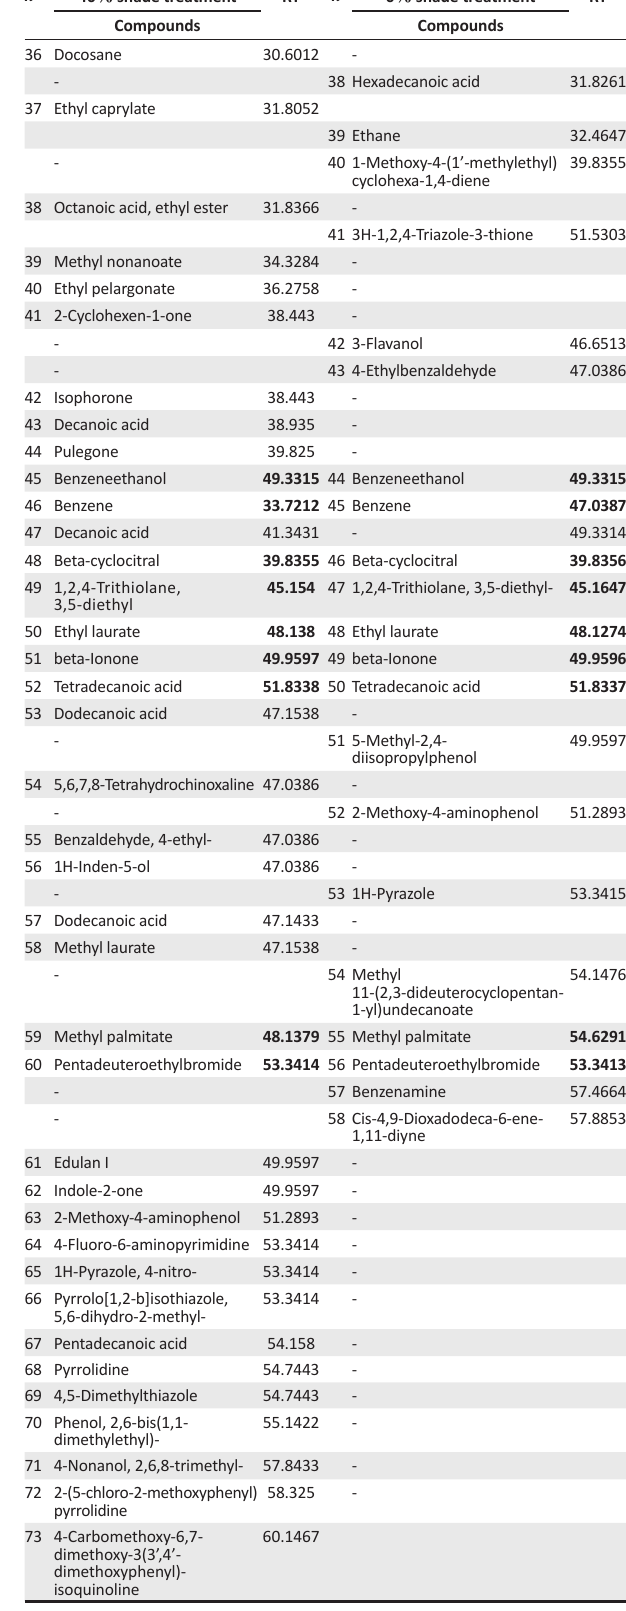
TABLE 2: Volatile compounds, with a mass spectral library match of at least 50%, present in aerial parts (leaf and bulb) of leek plants ( Allium porrum ) exposed to 40% shade and 0% shade for 12 weeks. n